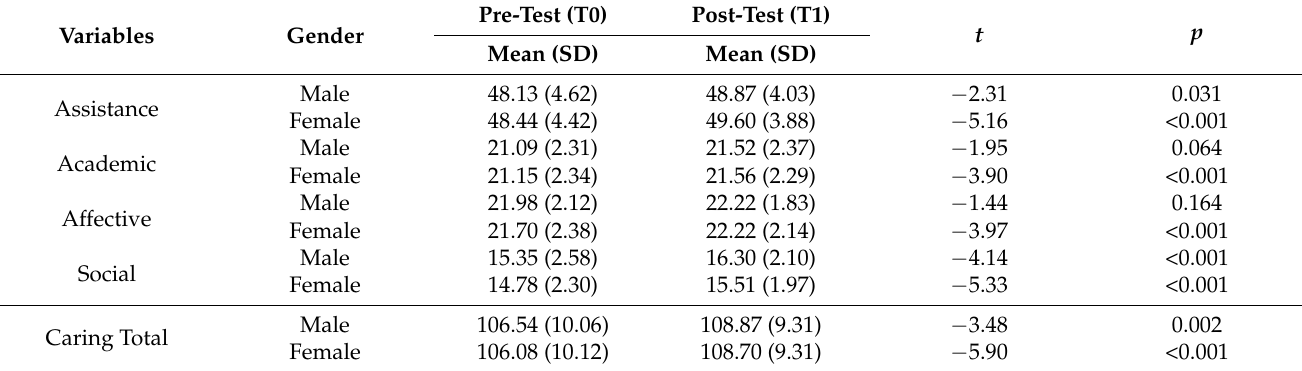
Table 2. Results of paired t -test in male and female students’ learning performances at pre-test and post-test.